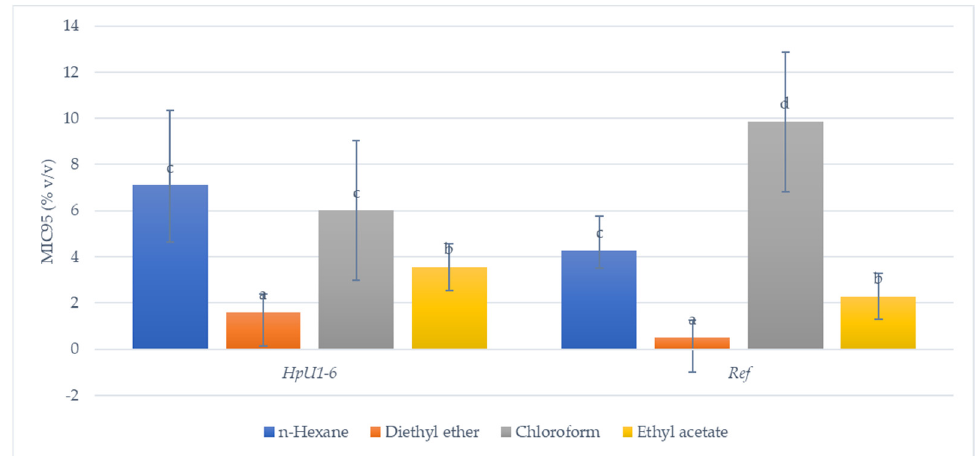
Figure 2. M IC 95 values (% v / v ) of h -hexane, diethyl ether, chloroform, and ethyl acetate oregano honey extracts against (6 ) H. pylori clinical strains ( HpU1–HpU6 ) isolated from ulcers and a reference honey extracts against (6) H. pylori clinical strains ( Hp U1– Hp U6) isolated from ulcers and a reference strain ( H. pylori DSM210321). strain ( H. pylori DSM210321). Different letters above bars indicate statistically significant differences (ANOVA with Tukey’s HSD, p < 0.05) for each group of